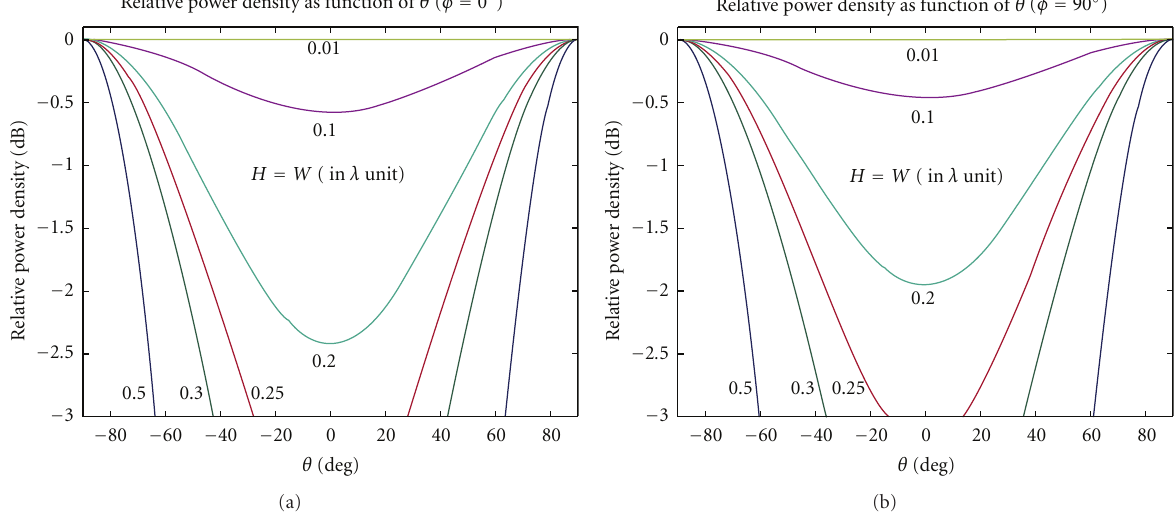
Figure 2: (a) E -plane radiation pattern ( ϕ = 0 ◦ cut) of the ideal λ/ 4 antenna element for H = W , measured in wavelengths. The pattern becomes more isotropic as W and H become smaller. (b) H -plane radiation pattern ( ϕ = 90 ◦ cut) of the ideal λ/ 4 antenna element for H = W , measured in wavelengths. The pattern becomes more isotropic as W and H become smaller.